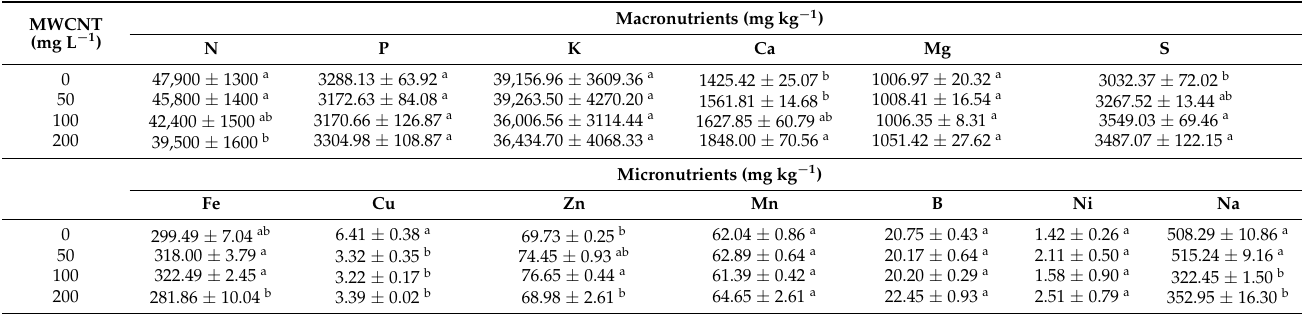
Table 1. Effect of multi-walled carbon nanotubes on macro- and micronutrient content of in vitro shoots of sugarcane ( Saccharum spp.) cv. Mex 69-290 in temporary